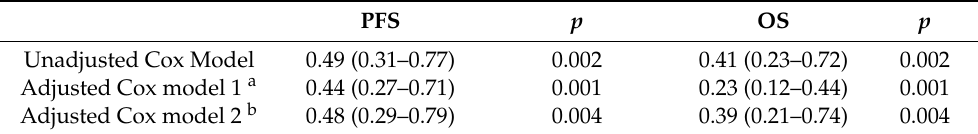
Table 3. Hazard ratio for progression-free survival (PFS) and overall survival (OS) for receiving pembrolizumab versus nivolumab.